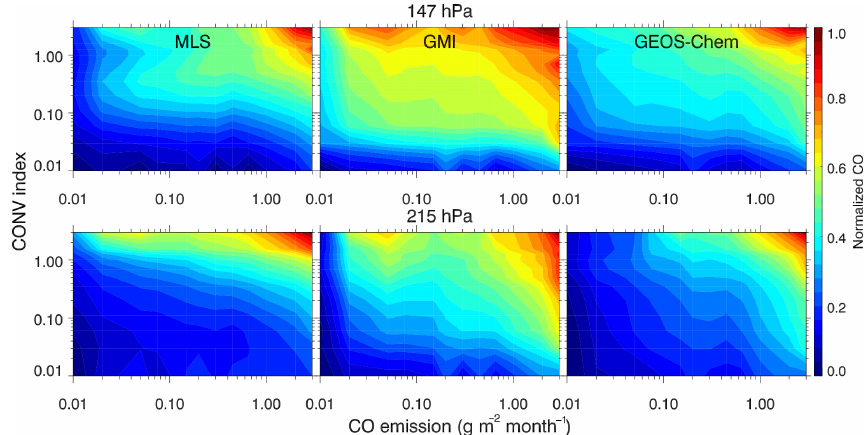
Figure 16. Contour plots of normalized CO mixing ratio at 215hPa (top row) and 147hPa (bottom row) over the tropics (30 ◦ S–30 ◦ N) from MLS observation (left column), GMI model simulation (middle column) and GEOS-Chem model simulation (left column) binned according to the surface CO emission ( x axis) and convective index ( y axis) at the same pressure level. See text for more